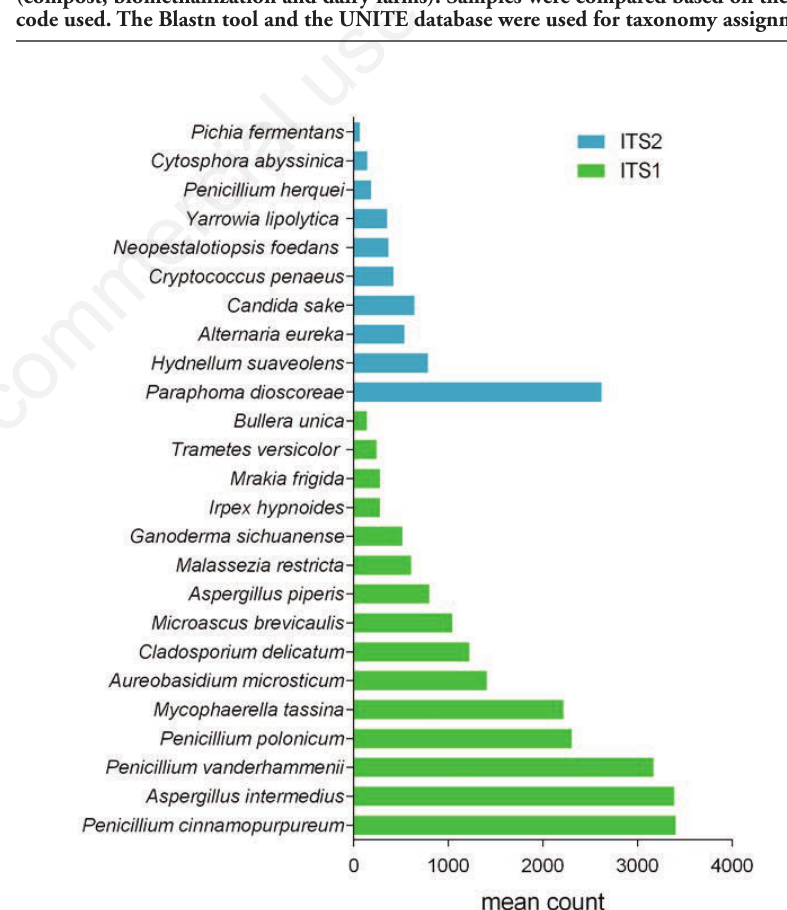
Figure 2. Fungal species with statistically significant differential abundances across sam- ples from compost, biomethanization and dairy farms targeting ITS1 or ITS2 barcodes. From the bottom to the top: 15 species that were consistently (throughout the three envi- ronments) more abundant using ITS1 and 10 that were consistently more abundant using